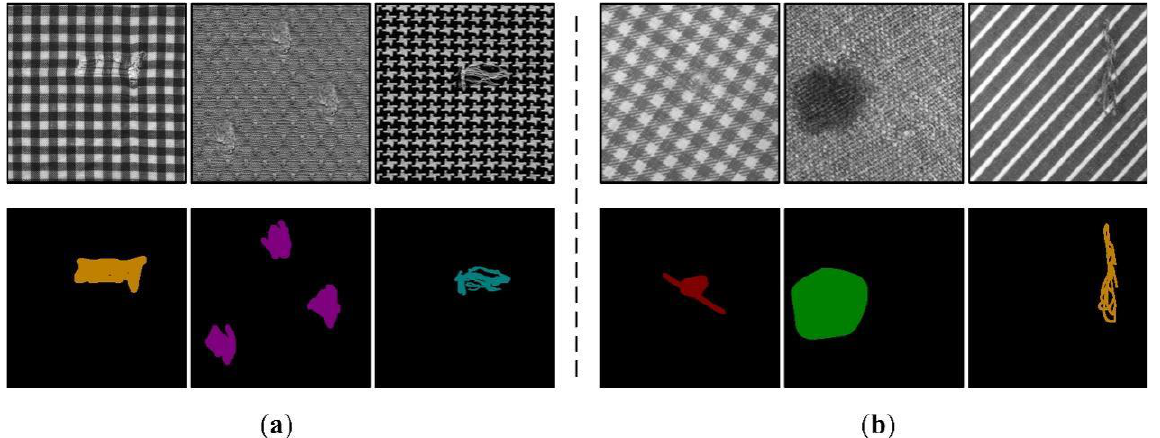
Figure 6. Some representative fabric images and their semantic labels, from ( a ) Fabric Images database, ( b ) TILDA database, respectively.